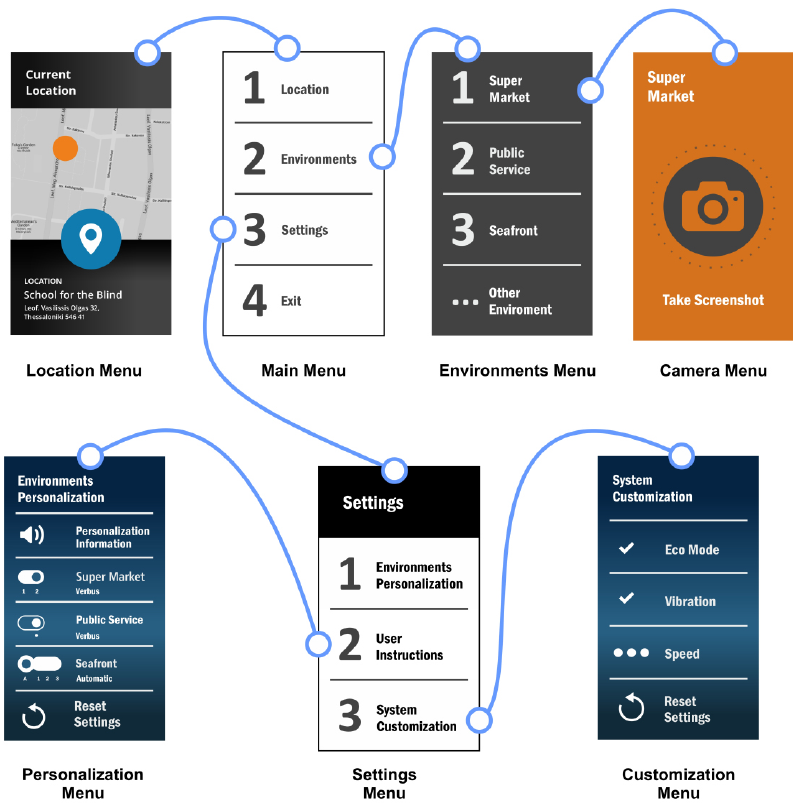
FIG. 2 Illustration of the user interface of the e-Vision application. Blue lines indicate the interface interconnections and